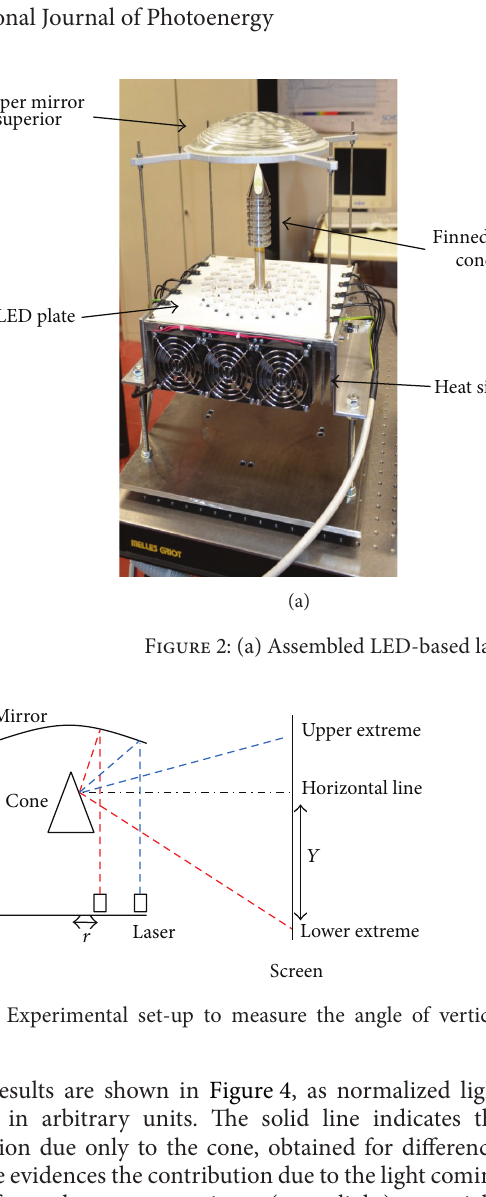
Figure 4: Normalized light intensity, in arbitrary units. Solid line: contributiononlyfromthecone.Itcanbeseenthatbeyondtherange − 29/18 degthecontributionislargelyduetothelightcomingdirectly from the concave mirror (stray